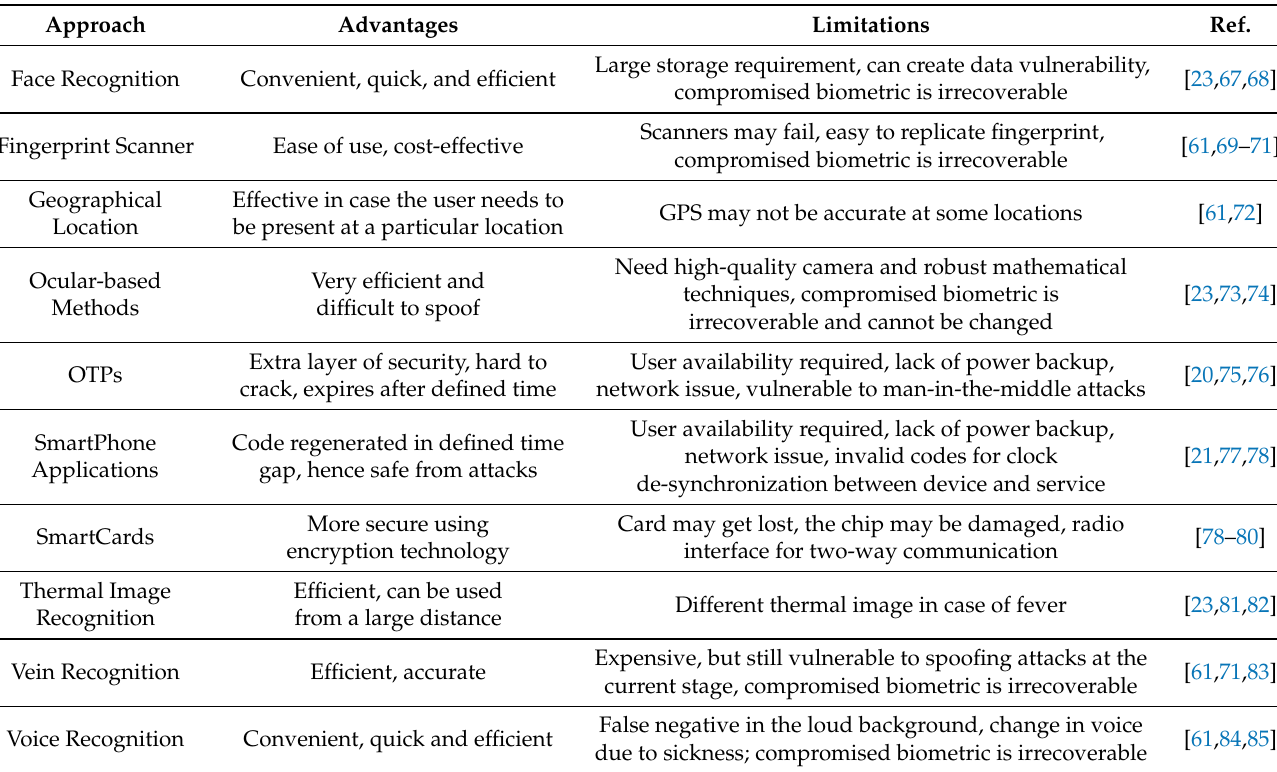
Table 2. Advantages and Limitations of Authentication Approaches.